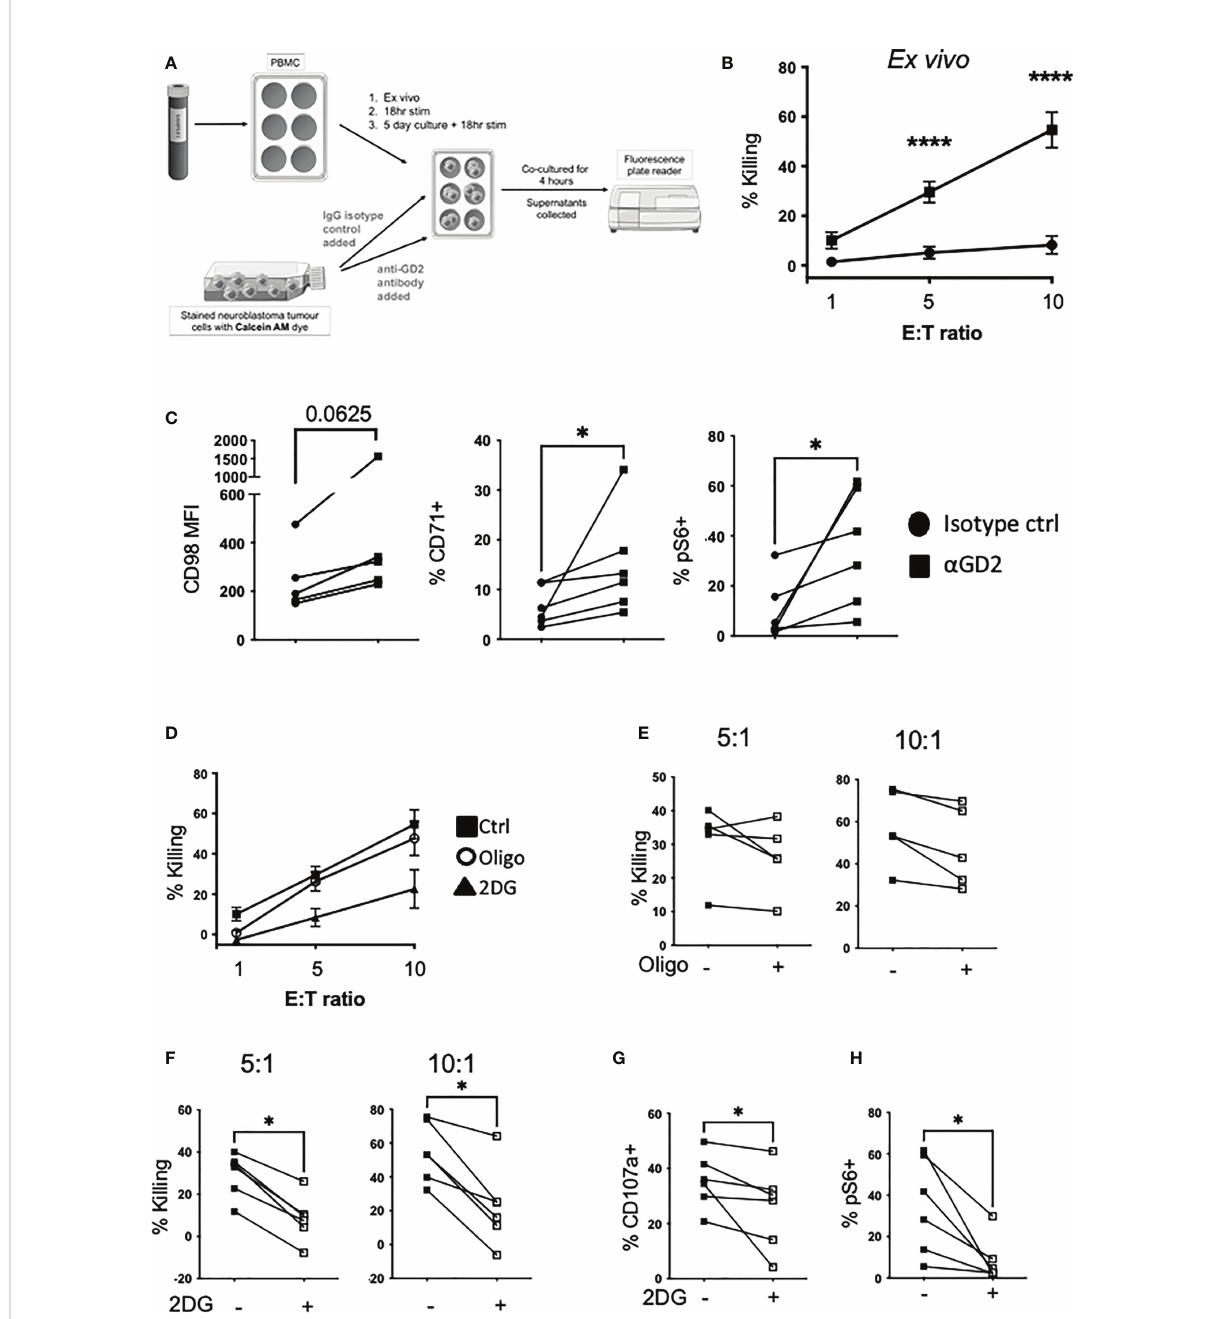
FIGURE 6 Glycolysis is required for NK cell a GD2-mediated killing of NB tumor cells. (A) Schematic of the setup of the ADCC assay. (B) Freshly isolated PBMC were cultured with Calcein AM-stained Kelly neuroblastoma cells at varying effector to target ratios (E:T) and incubated for 4 hrs at 37°C. (C) At the end of the assay, PBMC were stained for CD98, CD71 and pS6 analyzed by fl ow cytometry. (D) Oligomycin (40nM) and 2DG (2.5mM) was added for the 4 hour incubation. Golgi stop and anti-CD107a was added to measure degranulation. (E, F) Pooled data for the impact of oligomycin and 2DG on NK cells killing. (G) At the end of the assay, PBMC were stained for NK cell markers and pS6 and analyzed by fl ow cytometry. N=5-6. Samples were compared using the Two-way ANOVA test or Student ’ s t-test, *p<0.05,